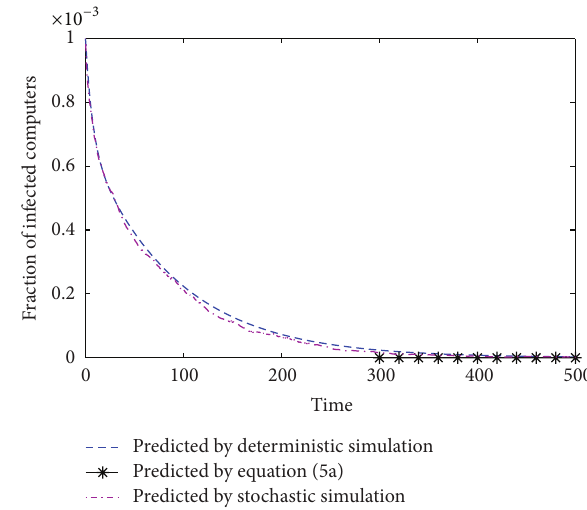
Figure 1: Fraction of infected computers when 𝑅 0 > 1 . (a) Blue (dash line): deterministic simulation; (b) black (solid line): theoretical value; (c) purple (dot-dash line): stochastic simulation.